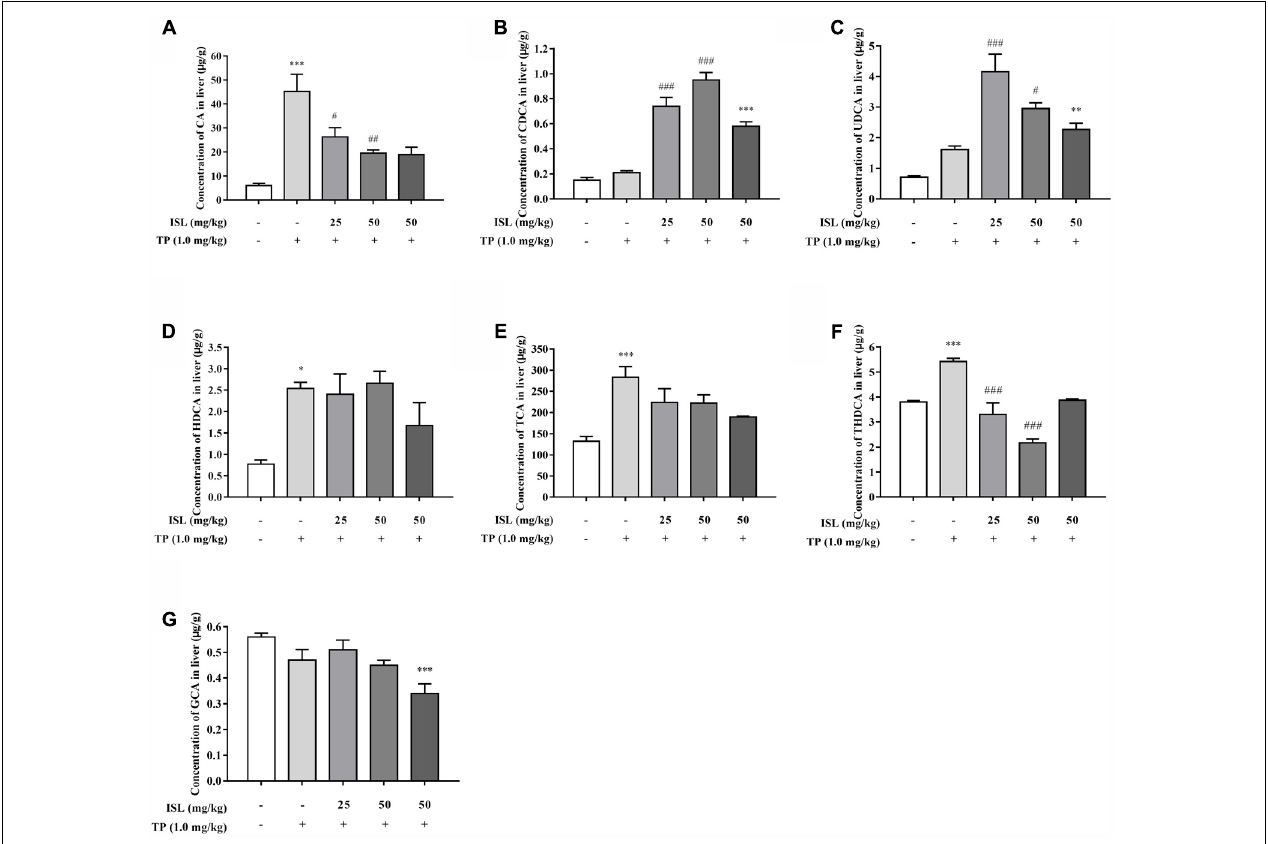
FIGURE 7 | Effects of TP, ISL, or ISL + TP on the hepatic bile acid (BA) profiles. Significant changes of hepatic concentration after TP or ISL administration were found in (A) CA, (B) CDCA, (C) UDCA, (D) HDCA, (E) TCA, (F) THDCA and (G) GCA. Concentrations of 16 BAs in mouse livers were quantified by liquid chromatography-tandem mass spectrometry. Data were presented as means ± SE ( n = 4–6); ∗ P < 0.05 vs. the control group, ∗∗ P < 0.01 vs. the control group, ∗∗∗ P < 0.001 vs. the control group, # P < 0.05 vs. the TP group, ## P < 0.01 vs. the TP group, and ### P < 0.001 vs. the TP